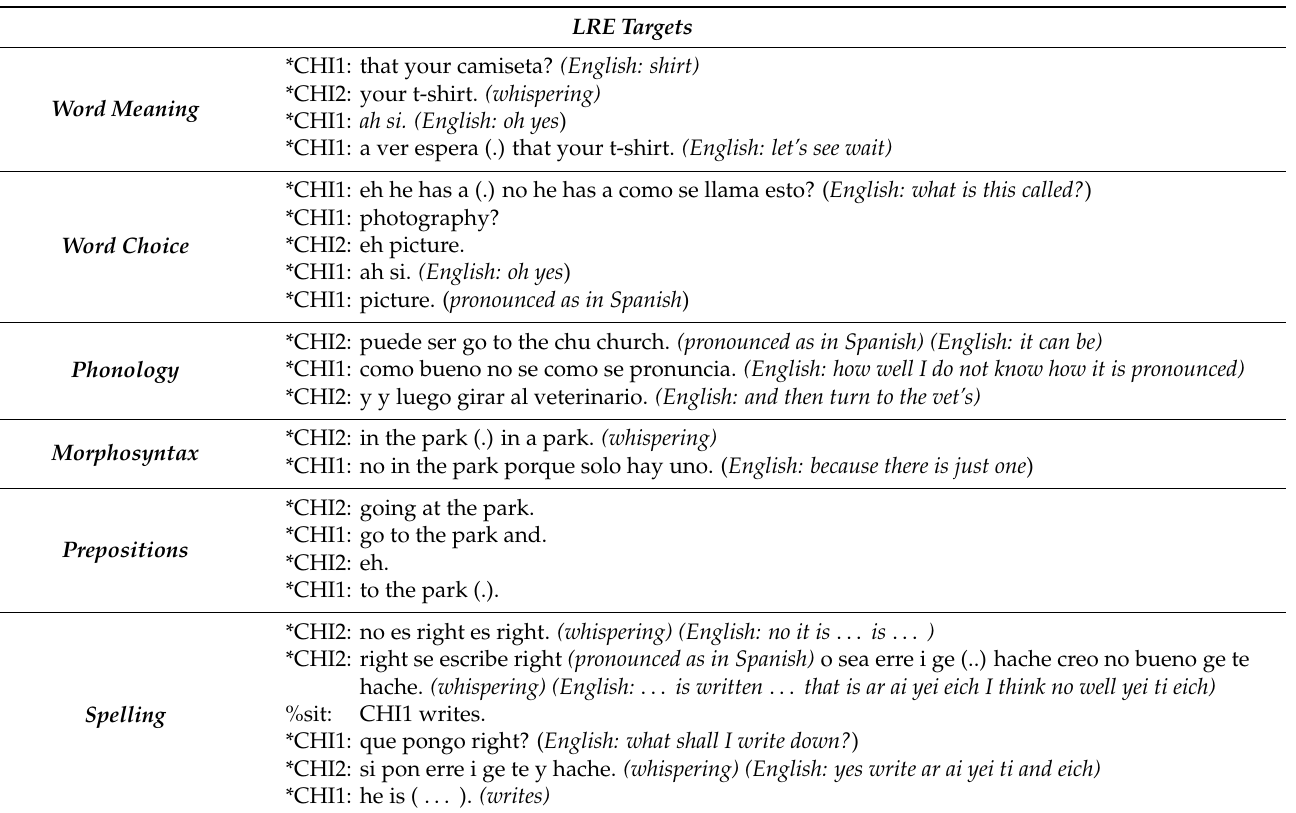
Table 2. Types of LRE targets.